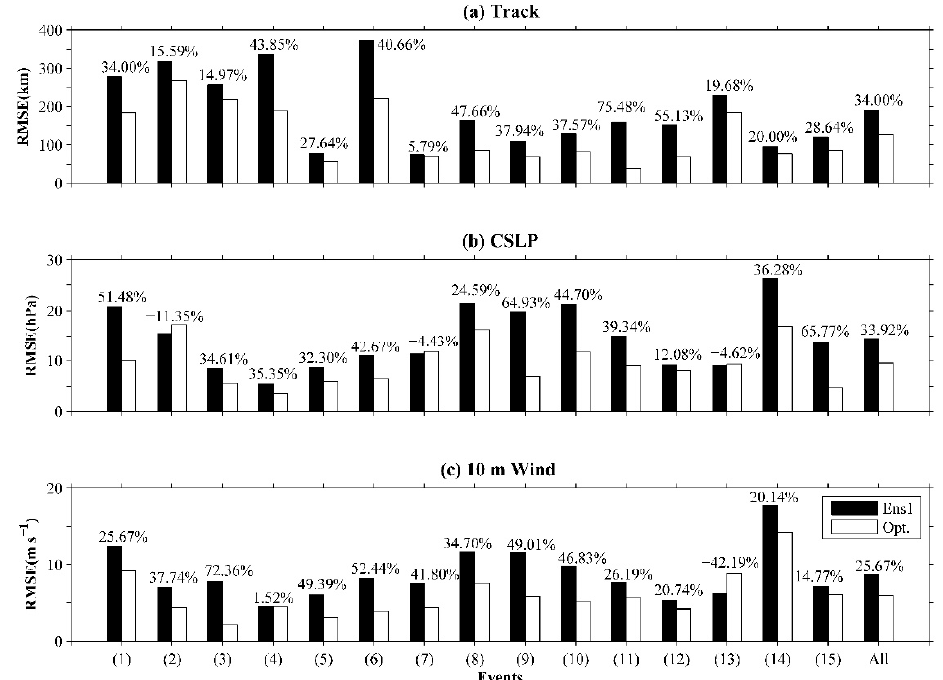
Figure 7. Comparisons of the simulation errors between Ens1 and the optimal scheme combination for the ( a ) track, ( b ) CSLP, and ( c ) 10-m wind of 15 typhoons.